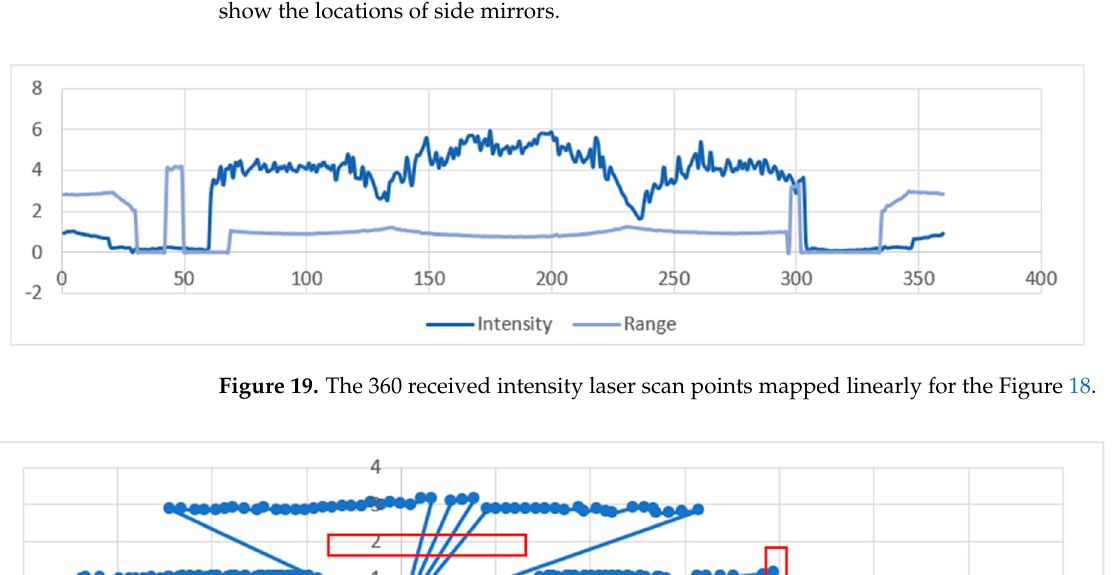
Figure 18. The 360 range mapping laser scan points mapped radially around the robot. The red boxes show the locations of side mirrors.